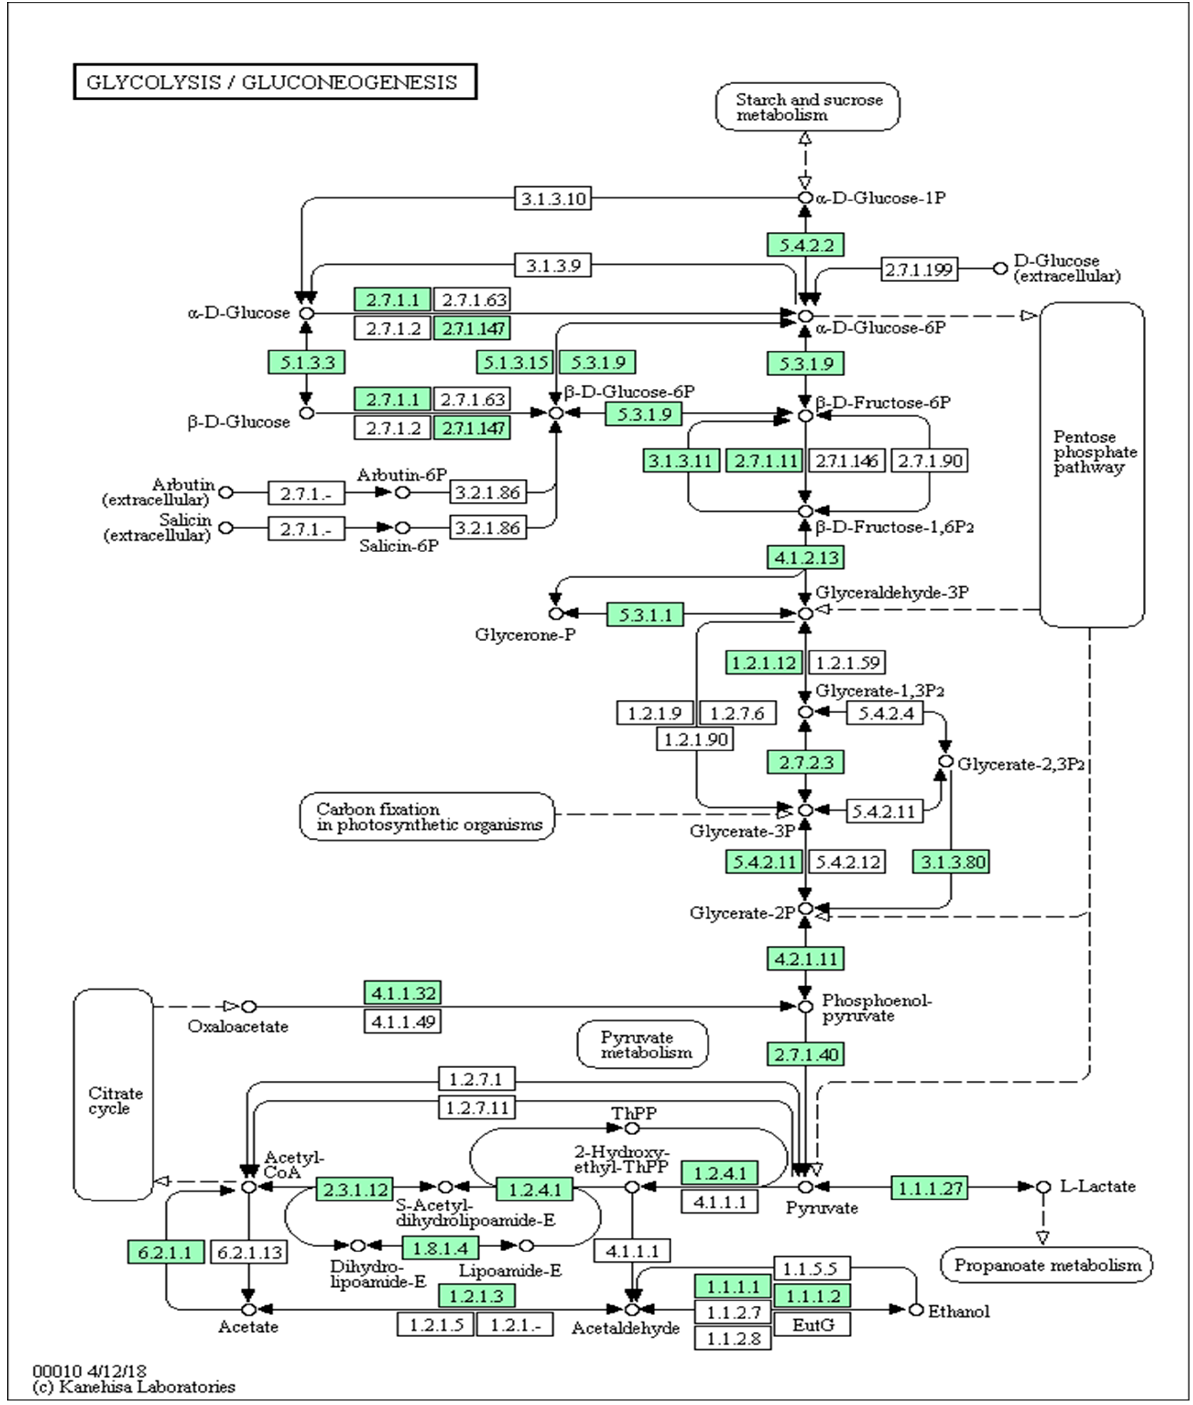
Figure 7. Fire ant glycolysis pathway, where components notated in green were upregulated in infected colonies.